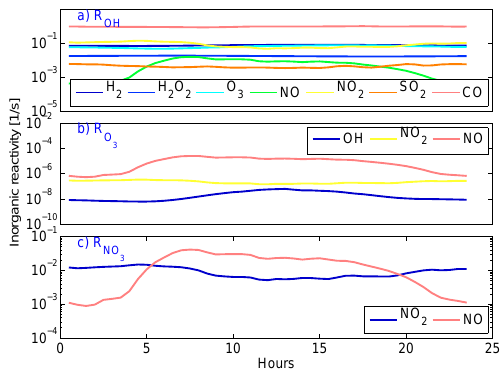
Figure 11. The daily averaged reactivity of OH (a) , O 3 (b) and NO 3 (c) at 18m due to reactions with specific individual inorganic compounds. Please note the log scale on the y